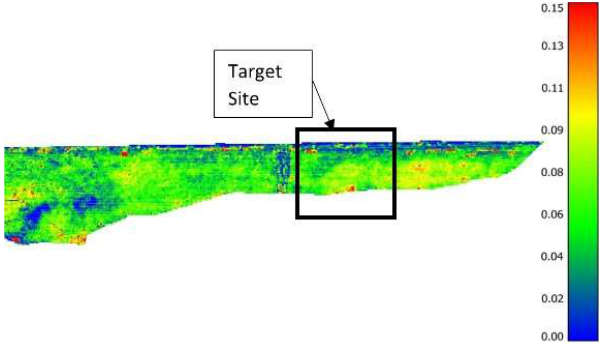
Figure 11. UAS-based deformation profile of Highway 84 (From Spring 2019 to Spring 2021, Unit of the color bar is in m).